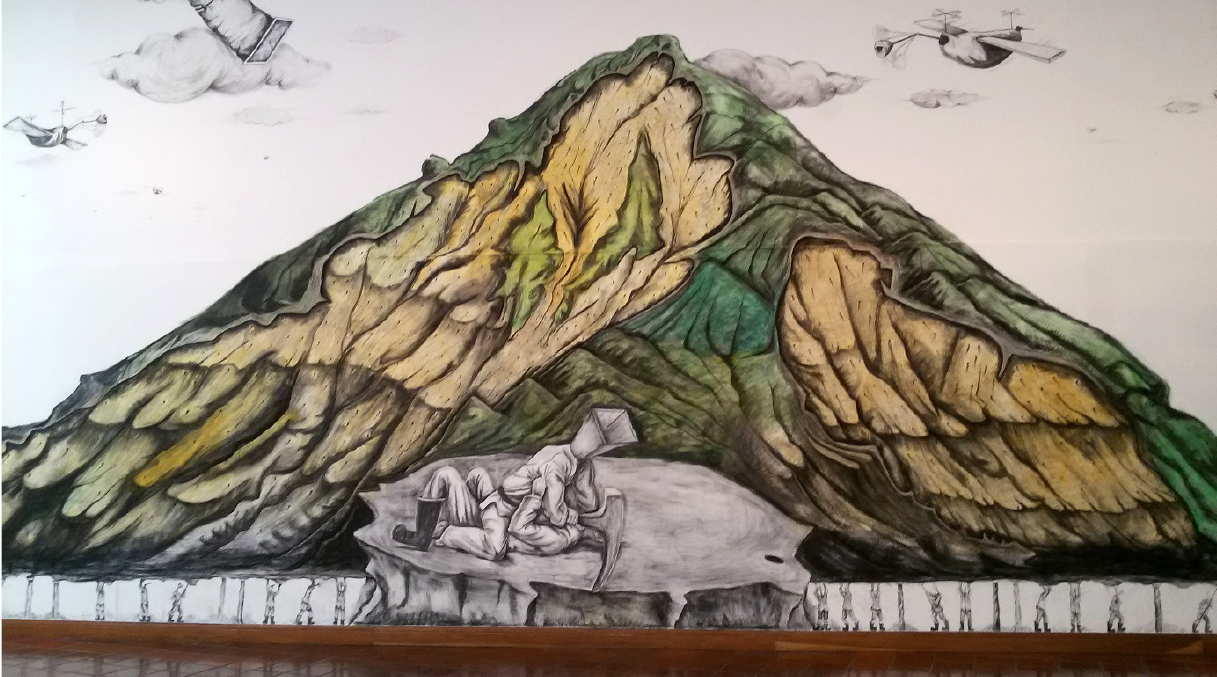
Figure 2. Escape de la Montaña / Mountain Escape (2016). Acrylic, charcoal and pastel on wall, 6.5 × 12